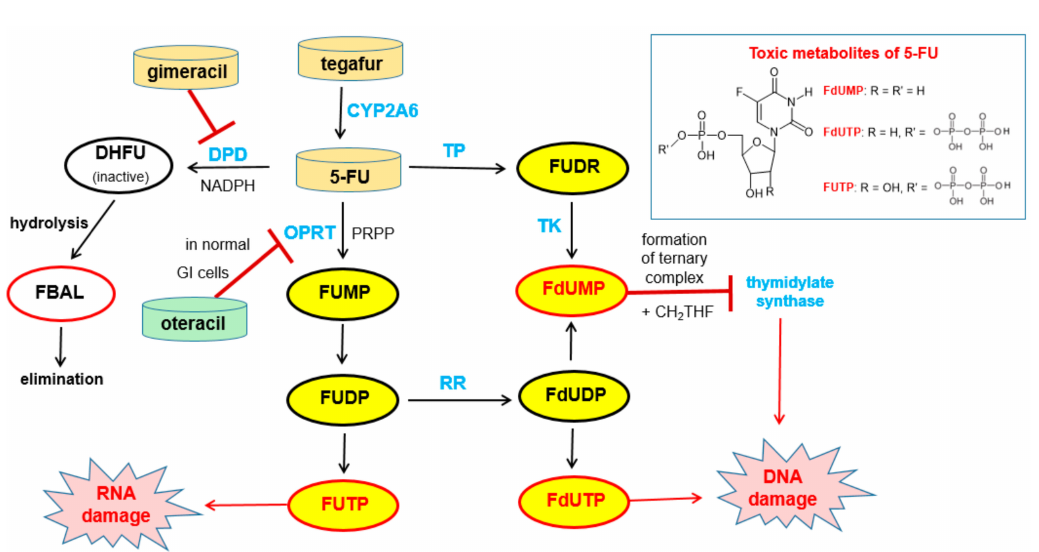
Figure 16. Bioactivation of tegafur to give 5-FU and subsequent metabolism of 5-FU (black arrows). The structures of the main toxic metabolites are shown in the box. Relevant enzymes are highlighted in blue. The biological effects of the toxic metabolites FUTP and FdUTP are indicated by red arrows. The effects of pharmacokinetic enhancers gimeracil and oteracil (both in Teysuno ® ) and of the active 5-FU metabolite FdUMP on enzymes are indicated by red bars. Abbreviations: 5-FU 5-fluorouracil, CH 2 THF methylene tetrahydrofolate, DHFU dihydrofluorouracil, DPD dihydropyrimidine dehydrogenase, FBAL fluoro- β -alanine, FdUDP fluorodeoxyuridine diphosphate, FdUMP fluorodeoxyuridine monophosphate, FdUTP fluorodeoxyuridine triphosphate, FUMP fluorouridine monophosphate, FUDP fluorouridine diphosphate, FUDR fluorodeoxyuridine, FUTP fluorouridine triphosphate, OPRT